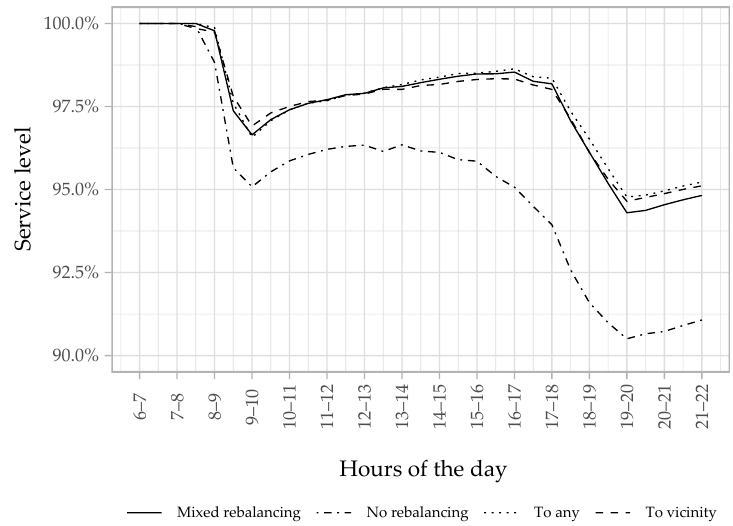
Figure 10. Variation of the service level during the day for 90 bikes.